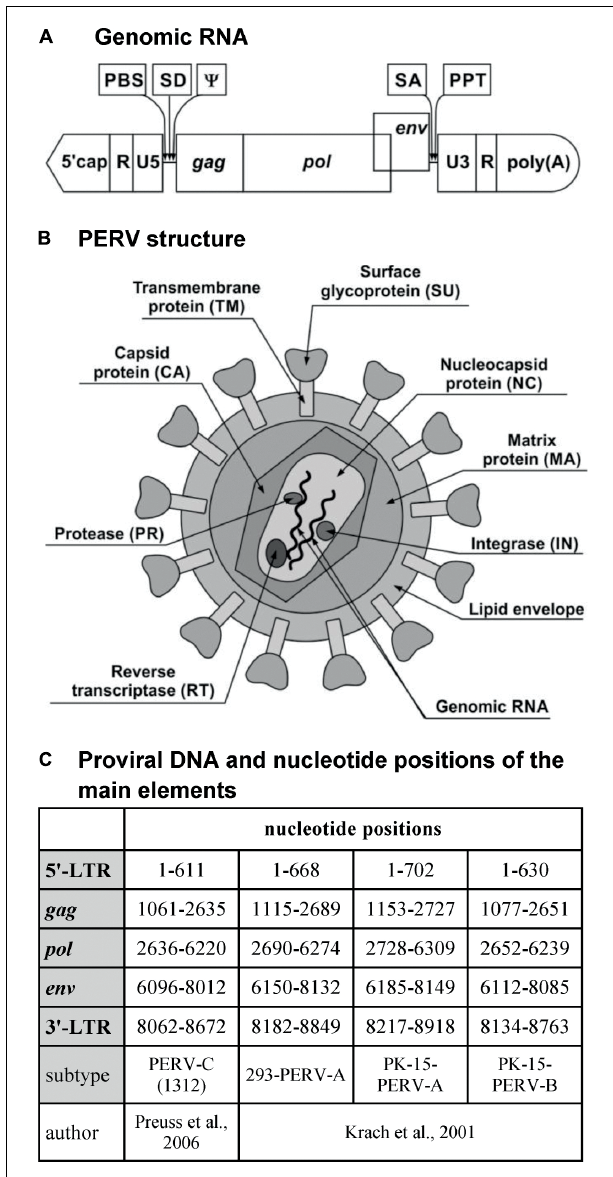
FIGURE 1 | PERV. (A) Genomic RNA. (B) PERV structure. (C) Proviral DNA and nucleotide positions of the main elements. PBS, primer-binding site; SD, splice donor site; ψ , packaging signal psi; SA, splice acceptor site; PPT, polypurine tract; MA, matrix; CA, capsid; NC, nucleocapsid; PR, protease; RT, reverse transcriptase; IN, integrase; SU, surface envelope protein; TM, transmembrane envelope protein; LTR, long terminal repeat; gag , group-specific antigen; pol , polymerase; env ,